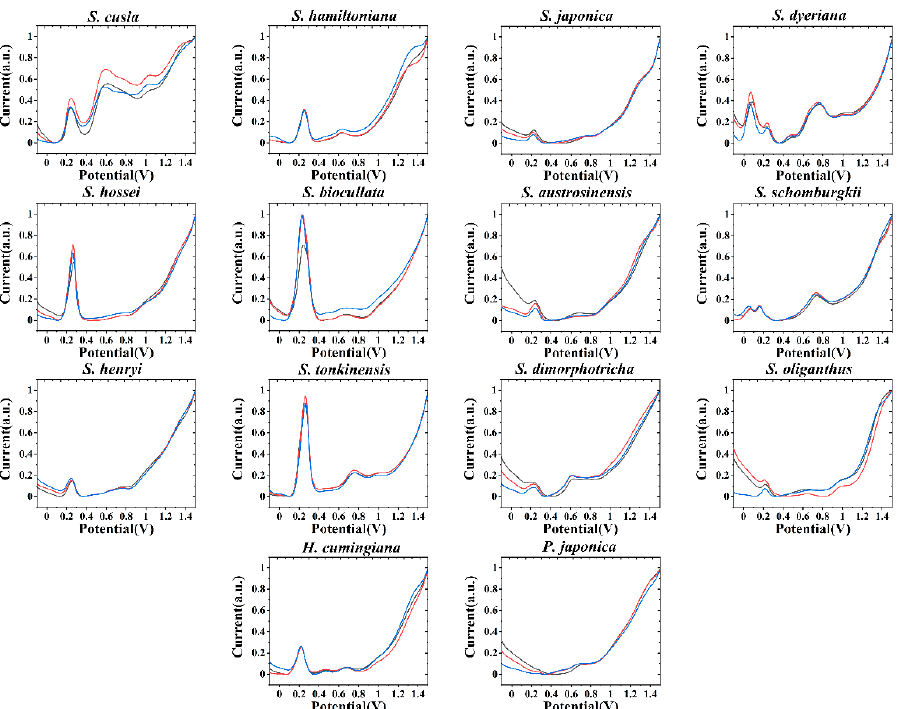
Figure 1. Electrochemical fingerprint of S. hossei, S. japonica, S. dimorphotricha, S. cusia, S. biocullata,